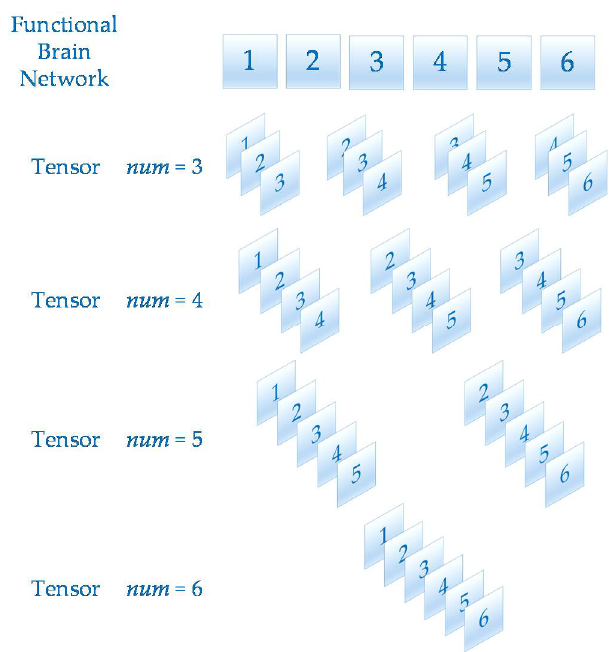
Figure 3. This figure shows the tensor construction of different num